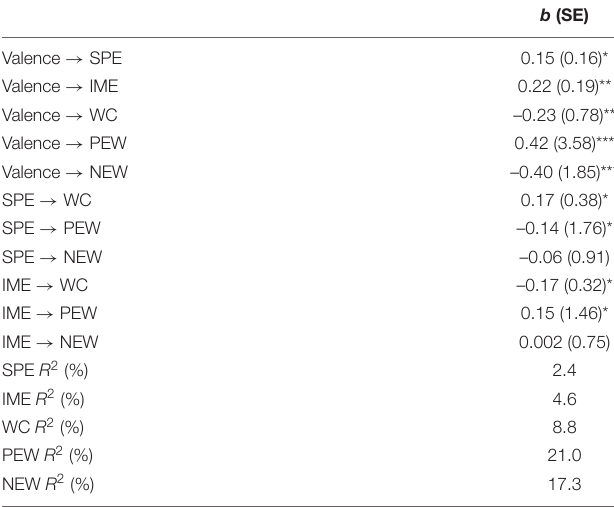
TABLE 2 | Regression Coefficients and R 2 of the Path Model.